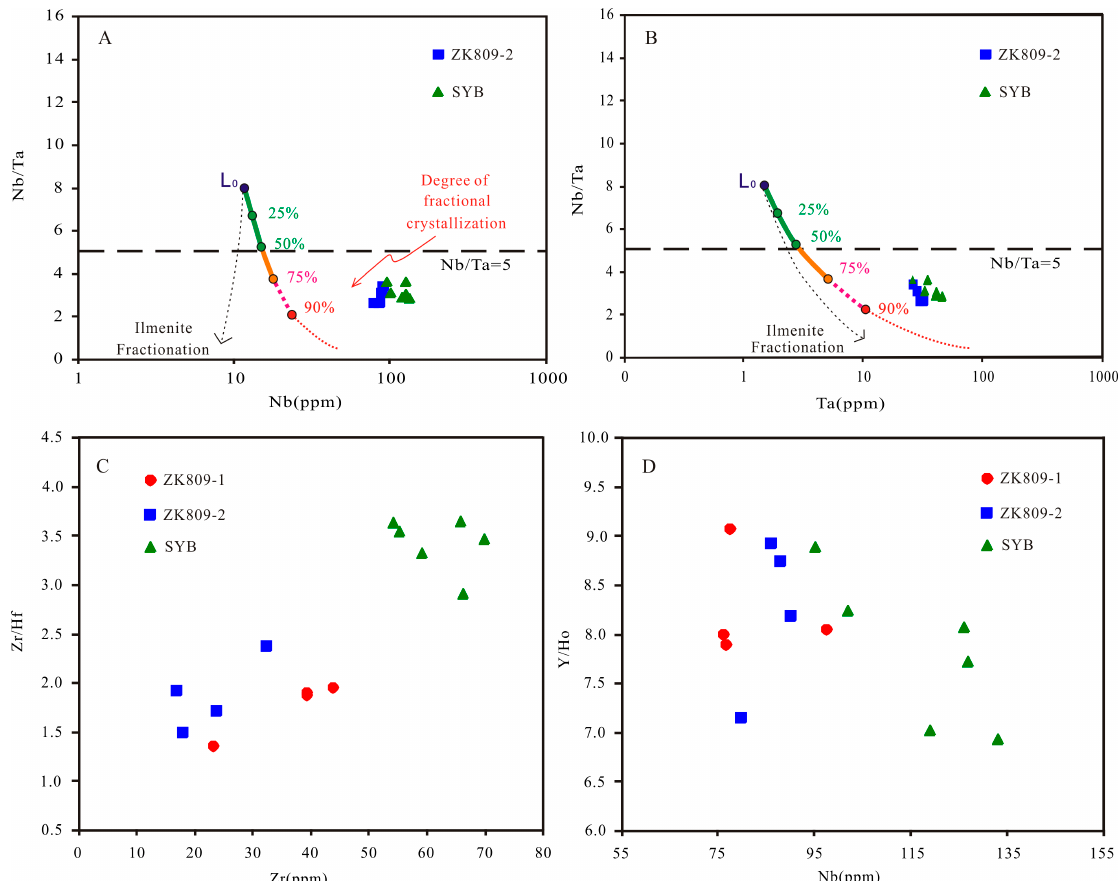
Figure 12. ( A ) Nb versus-Nb/Ta diagram (Ballouard et al. [78]); ( B ) Ta versus Nb/Ta diagram (Ballouard et al. [78]); ( C ) Zr versus Zr/Hf diagram; ( D ) Nb versus Y/Ho diagram.